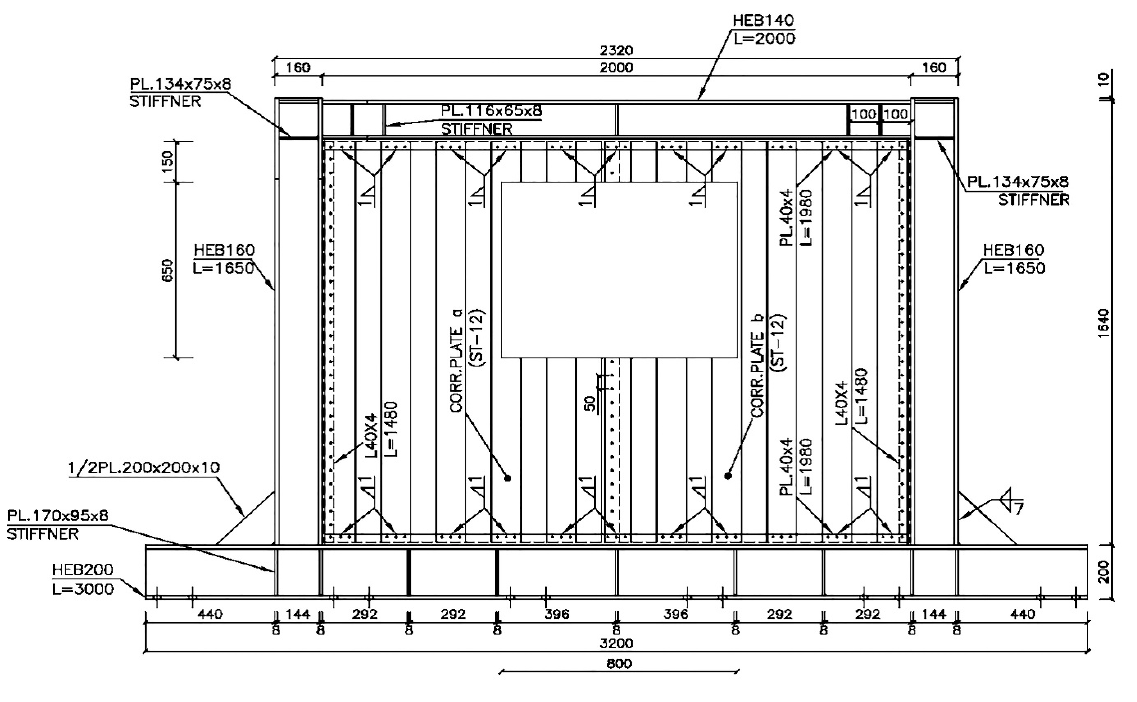
Figure 1. Details of specimen 1 (mm).